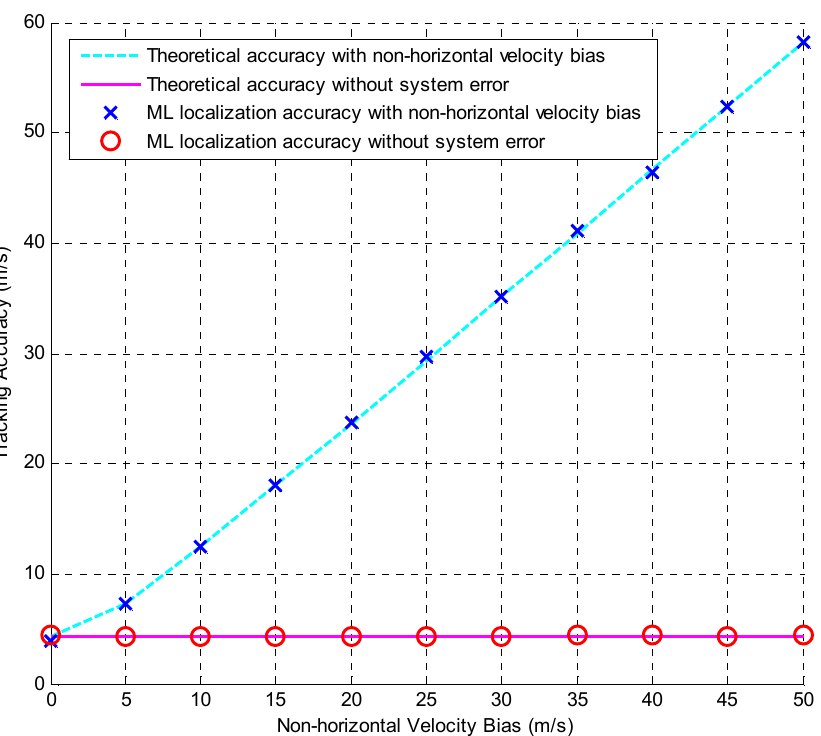
Figure 12. Comparison of velocity estimation using LEO satellite, airplane and ground station by varying non-horizontal velocity bias.